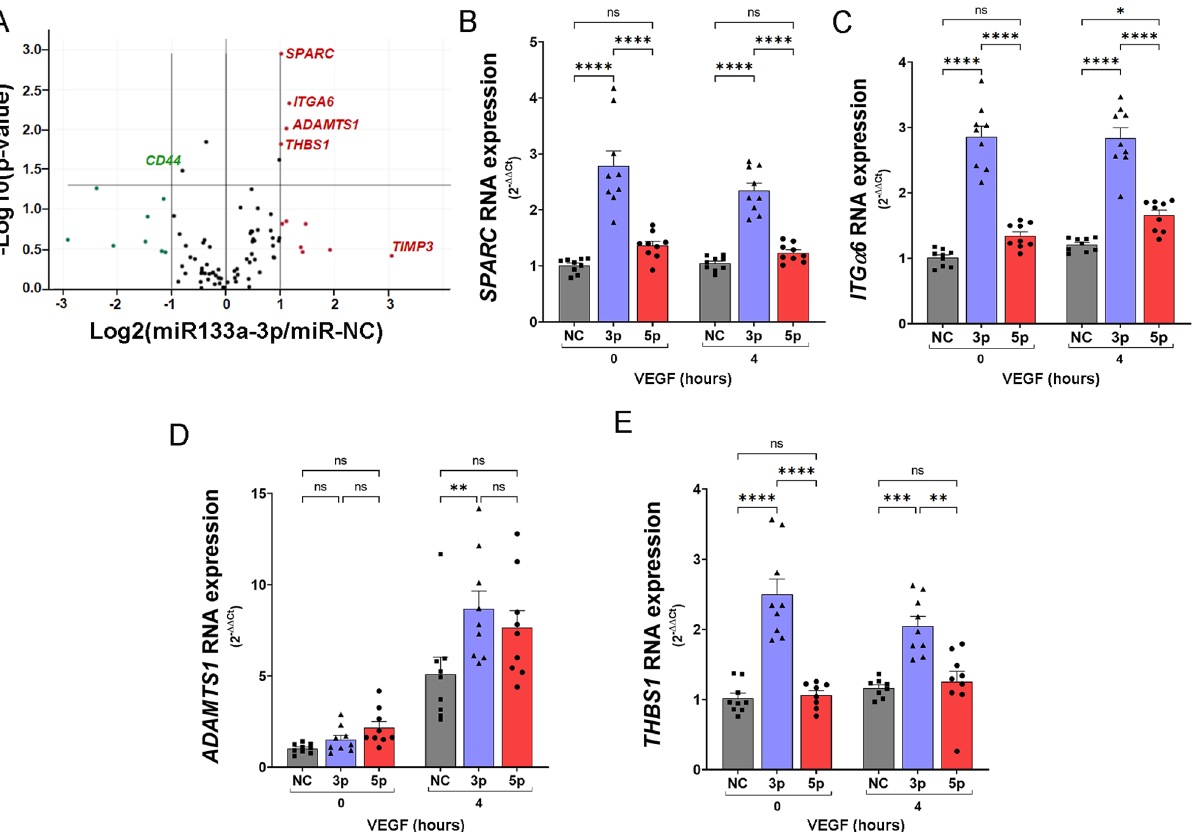
Figure 5. Ectopic expression of miR-133a-3p alters the expression of key mediators of ECM remodelling. ( A ) Volcano plot representation showing differential gene expression analysis of a RT2 Profiler PCR Array Human Extracellular Matrix & Cell Adhesion Molecules Kit (Ref PAHS-013Z, Qiagen) using RNA isolated from HUVEC transfected with miR-133a-3p or negative control (miR-NC) and stimulated for 4 h with VEGF-A 165 (50 ng/ml). Results of three independent experiments were analysed using GeneGlobe Data Analysis Center (Qiagen). Genes showing a Log2(miR-133a-3p/miR-NC) > 1 and − Log10( P value) P ≤ 0.05 were selected as upregulated (red). Those with Log2(miR-133a-3p/miR-NC) < − 1, and − Log10( P value) P ≤ 0.05 were selected as downregulated (green). ( B – E ) HUVEC transfected with mimics for negative control (NC, grey bars), miR-133a-3p (3p, blue bars) or miR-133a-5p (5p, red bars) were left unstimulated (0 h) or stimulated with VEGF-A 165 (50 ng/ml) for 4 h. RNA isolated from these cells were used to determine changes in gene expression using qPCR TaqMan Gene Expression Assays specific for each gene. Data are shown as mean ± SE, n = 8. Data were analysed for statistical differences by two-way ANOVA with post hoc Tukey’s comparison test. ns = non- significant; *, P ≤ 0.05; **, P ≤ 0.01; ***, P ≤ 0.001; ****, P ≤